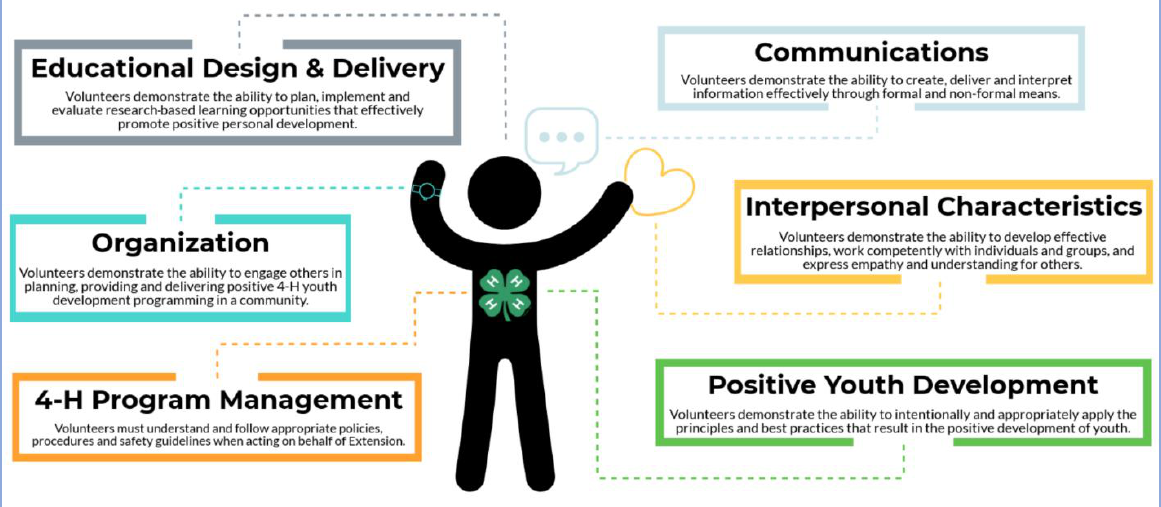
Figure 1. Volunteer Research Knowledge and Competency (VRKC) Taxonomy